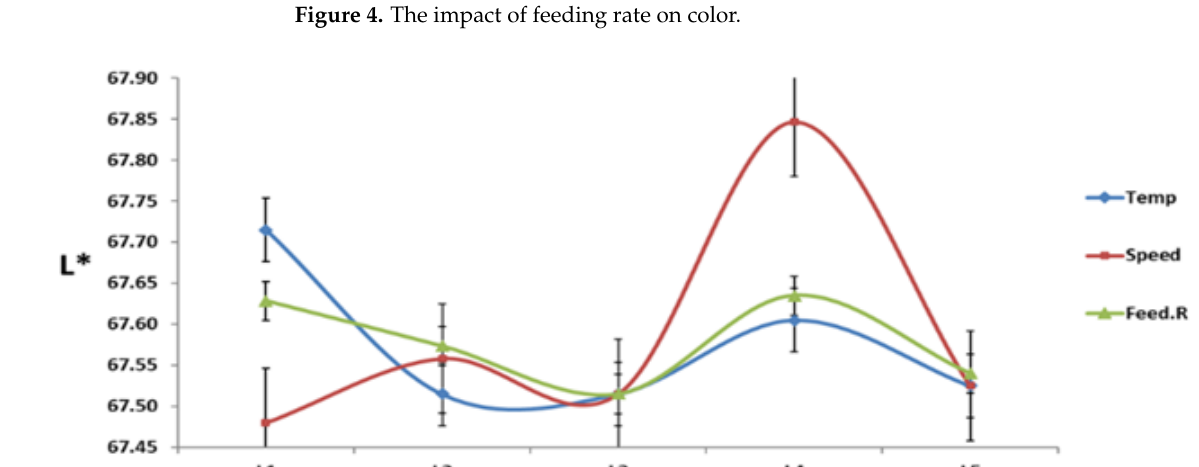
Figure 4. The impact of feeding rate on color.